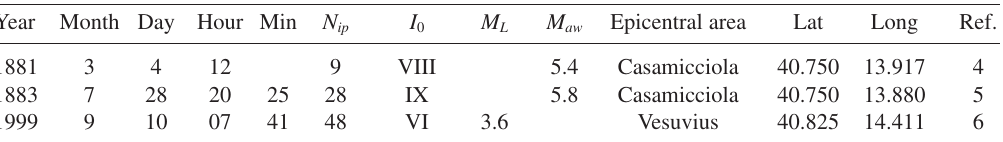
Fig. 4. Distribution of the epicentres and related 117 intensity site observations concerning the 6 earthquakes used for the Aeolian Islands (listed in table II). Symbols as in fig. 2. The white star and the cross represent, re- spectively, the macroseismic and instrumental epicentres of the 1978 Gulf of Patti Table III. Dataset of the earthquakes selected for the Vesuvius-Ischia district. M aw , moment magnitude from CPTI Working Group (2004). Source of data: 4) SGA (2002); 5) Boschi et al . (2000); 6) Cubellis and Martura- no (2002).